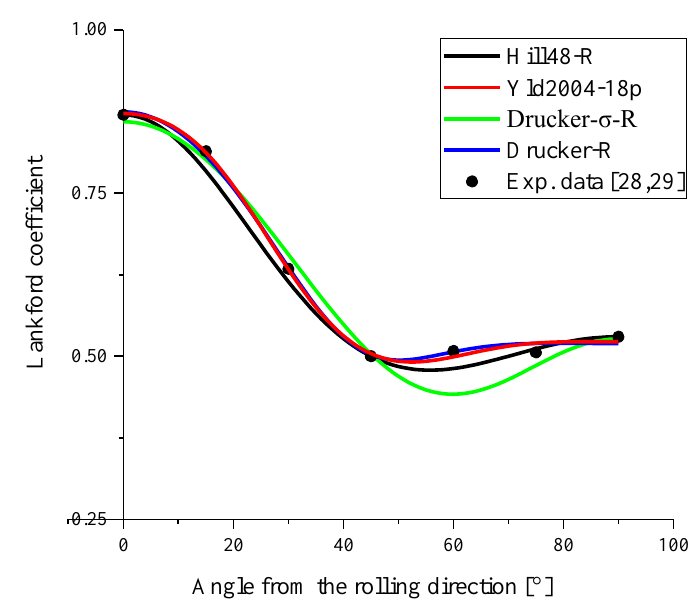
Figure 7. The R-value directionality with four yield functions for AA 2090-T3 sheet.